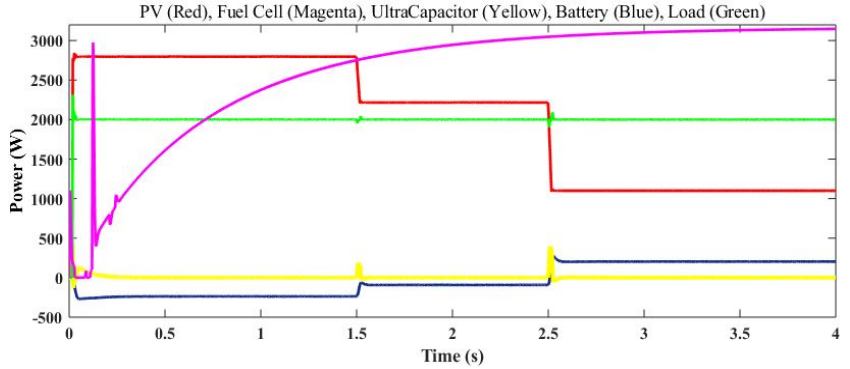
Figure 17. Total output power.